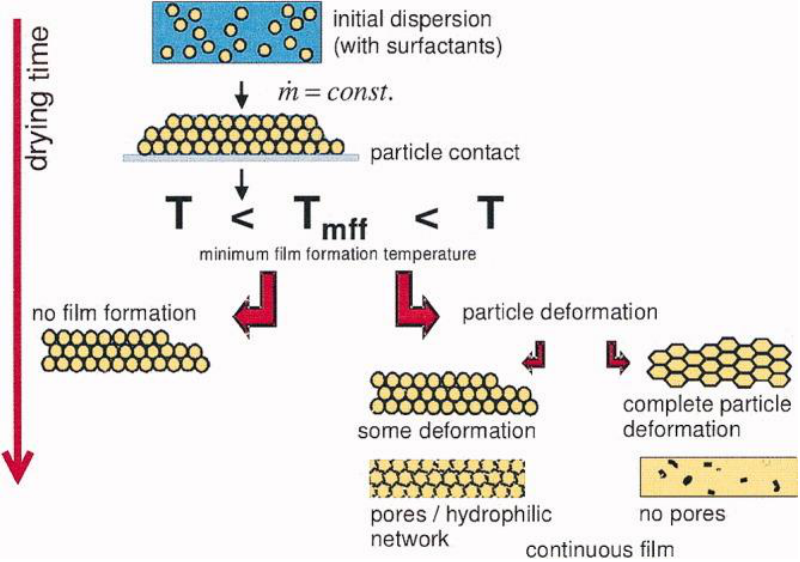
Figure 1. Film formation from water dispersions of polymer nanoparticles (PNPs). Water evaporation leads to a PNP packing, which deform above a minimum film formation temperature ( T mff ), as a result of surface tension and capillary forces. Complete particle deformation and chain interdiffusion at T > T g leads to a continuous non-porous film. Reprinted with permission from ref. [8]. Copyright 2007 American Institute of Chemical Engineers (AIChE).